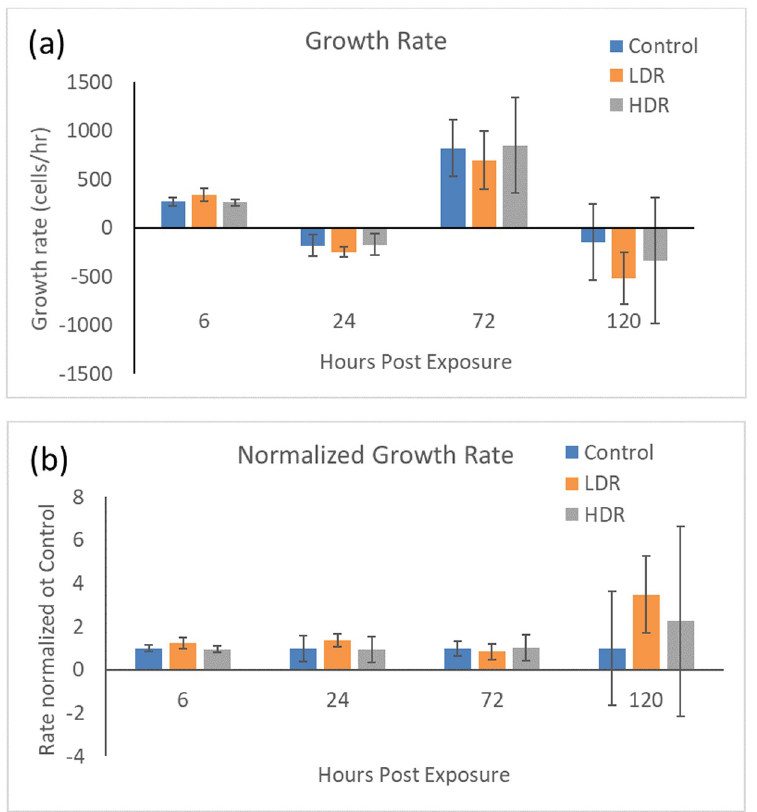
Fig 2. a) Cell growth rate after 2Gy gamma irradiation. b) Irradiated sample growth rates normalized to control at each time point. N = 3 independent experiments for each time point.